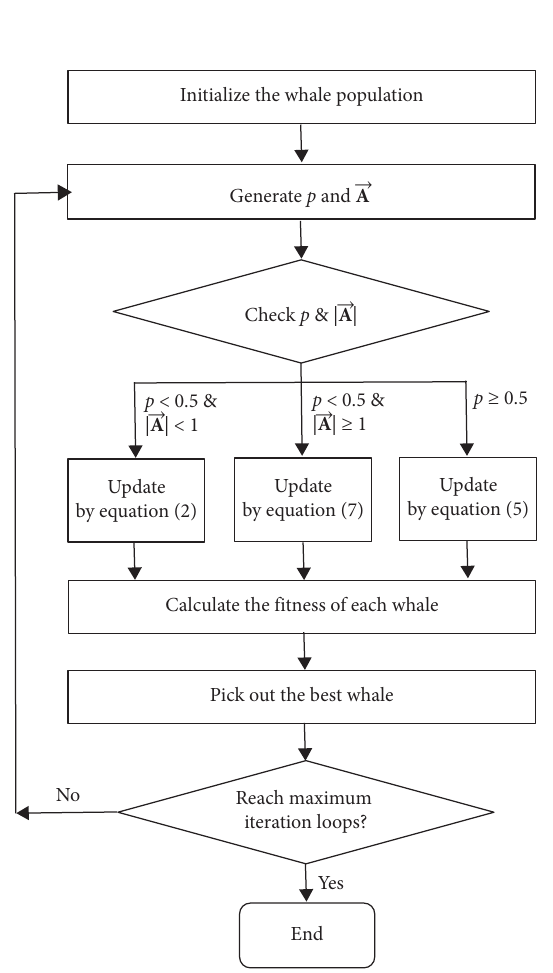
Figure 2: The flowchart of the whale optimization